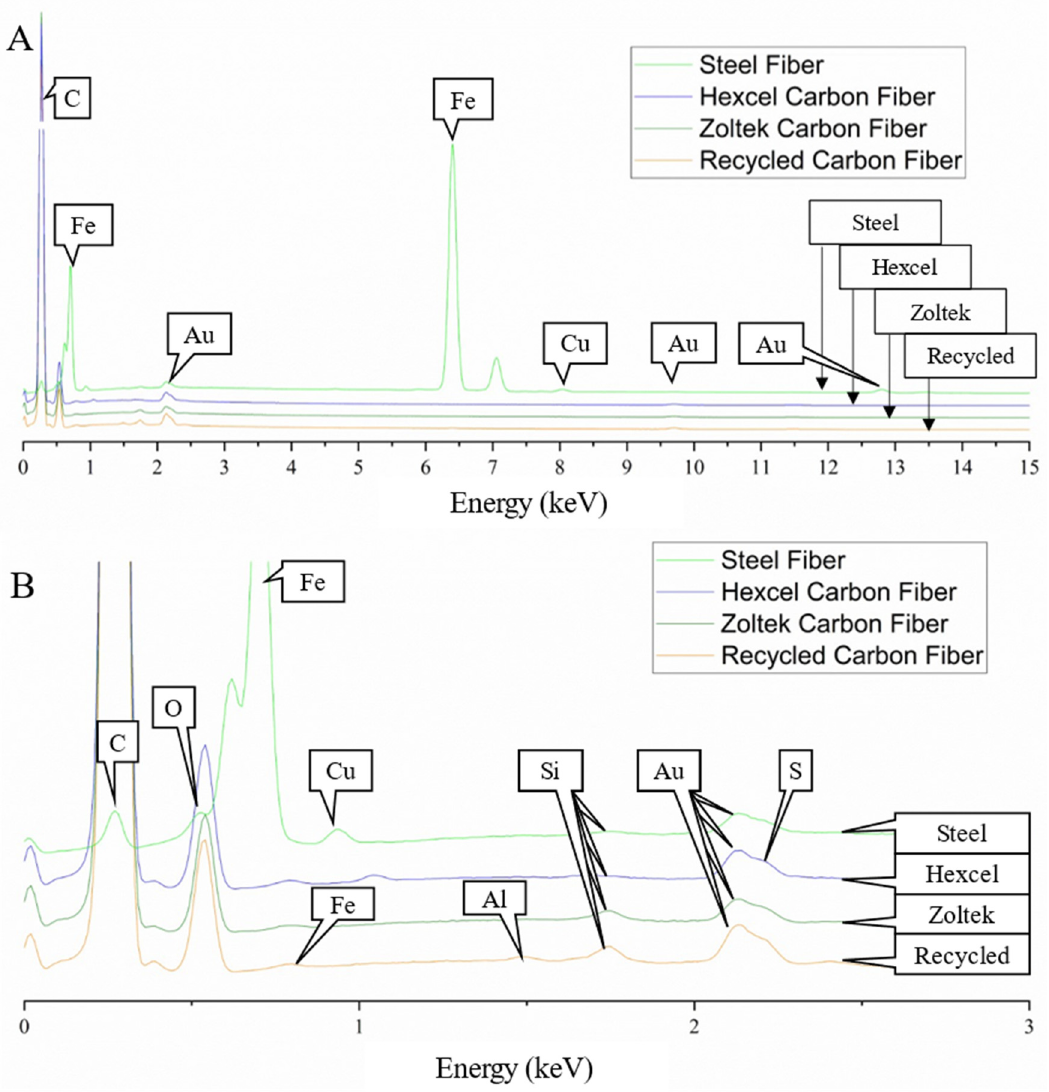
Figure 5. Energy dispersive X-ray spectra of the steel, Hexcel, Zoltek, and recycled carbon fibers, showing the elemental chemical composition of each fiber type. ( A ) Full energy spectrum from 0 keV to 15 keV; and ( B ) inset of energy-dispersive X-ray spectra energy range from 0 to 3 keV for each fiber type. The Au peaks correspond to the Au sputtering of the samples.